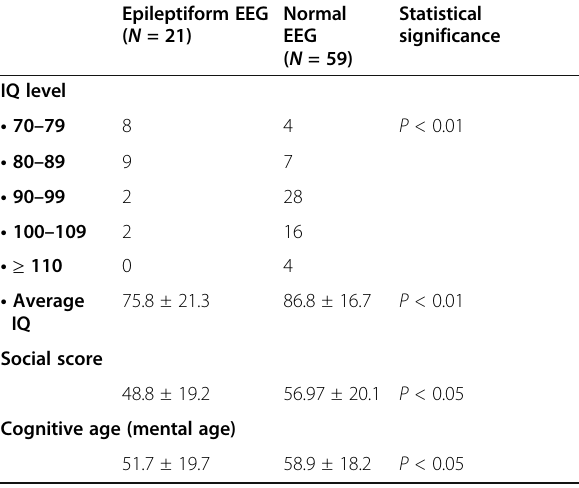
Table 3 IQ level, social, and cognitive age assessment in epileptic cases compared with cases with normal EEG